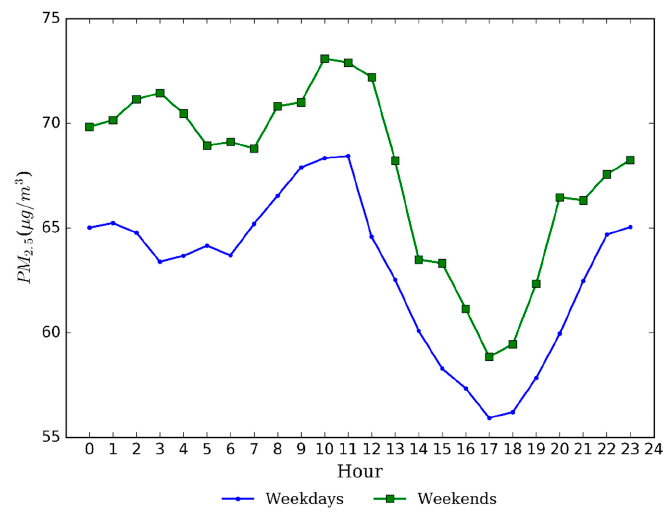
Figure 6. Weekday and weekend variations of PM 2.5 concentrations in Nanjing.